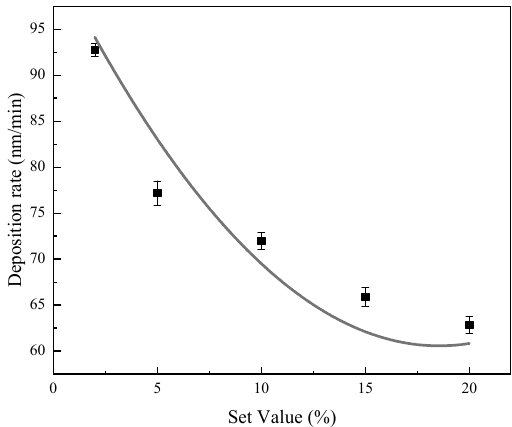
Figure 6. Deposition rates of Cr-DLC films as a function of the set value.